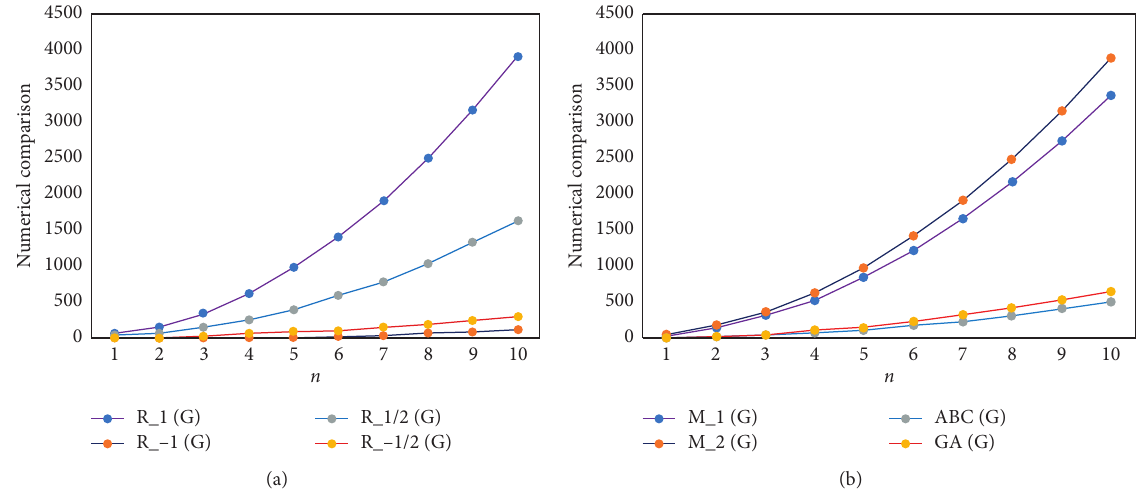
Figure 7: (a) Comparison of R